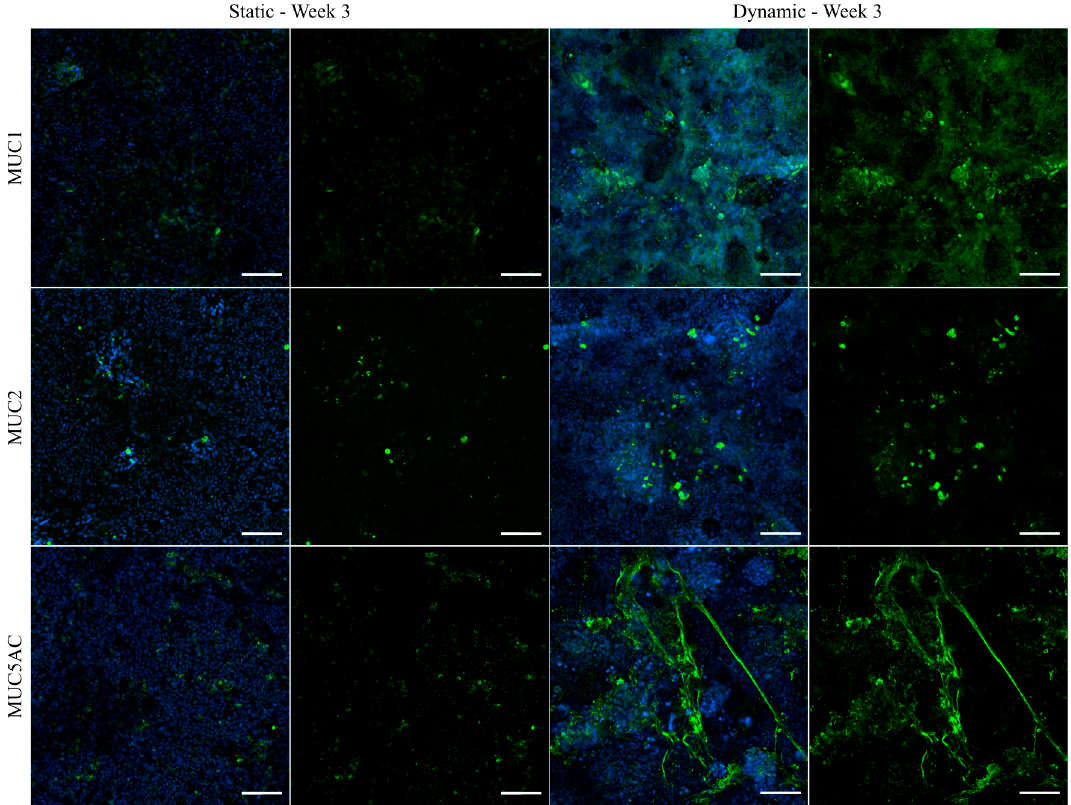
Figure 5. Confocal immunofluorescence images of HT29-MTX cells under static and dynamic conditions after three weeks. Samples were stained with antibodies for the membrane-bound mucin MUC1 and secreted mucins MUC2 and MUC5AC (green). Nuclei were counterstained with Hoechst 33342 (blue). (Scale bars: 100 µm).